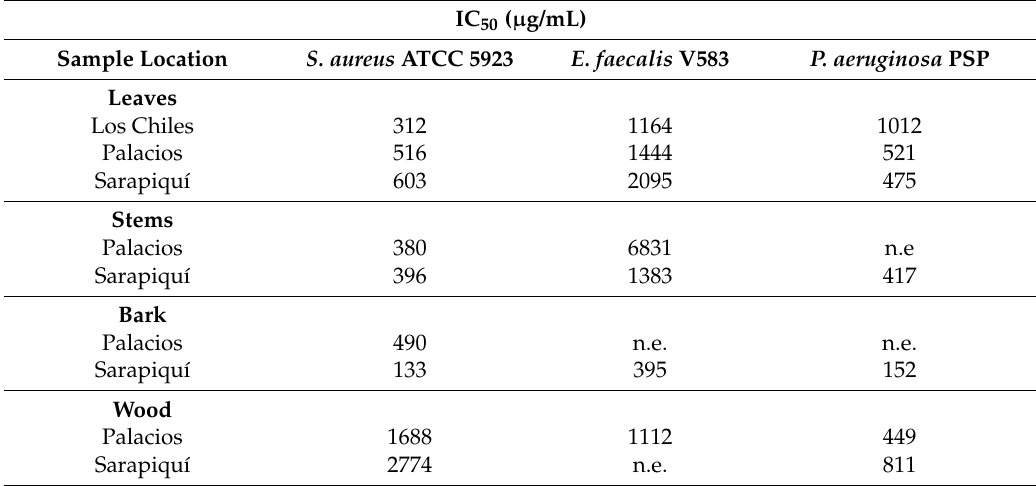
Table 4. Antimicrobial activity of U. tomentosa extracts against potential respiratory